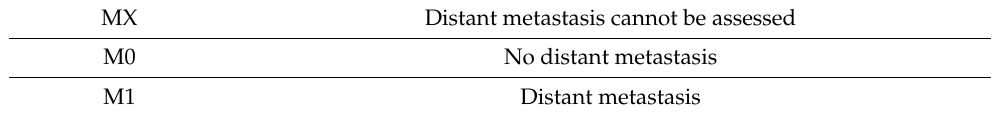
Table 3. Distant Metastasis from TNM (8th Edition) classification system for cervical